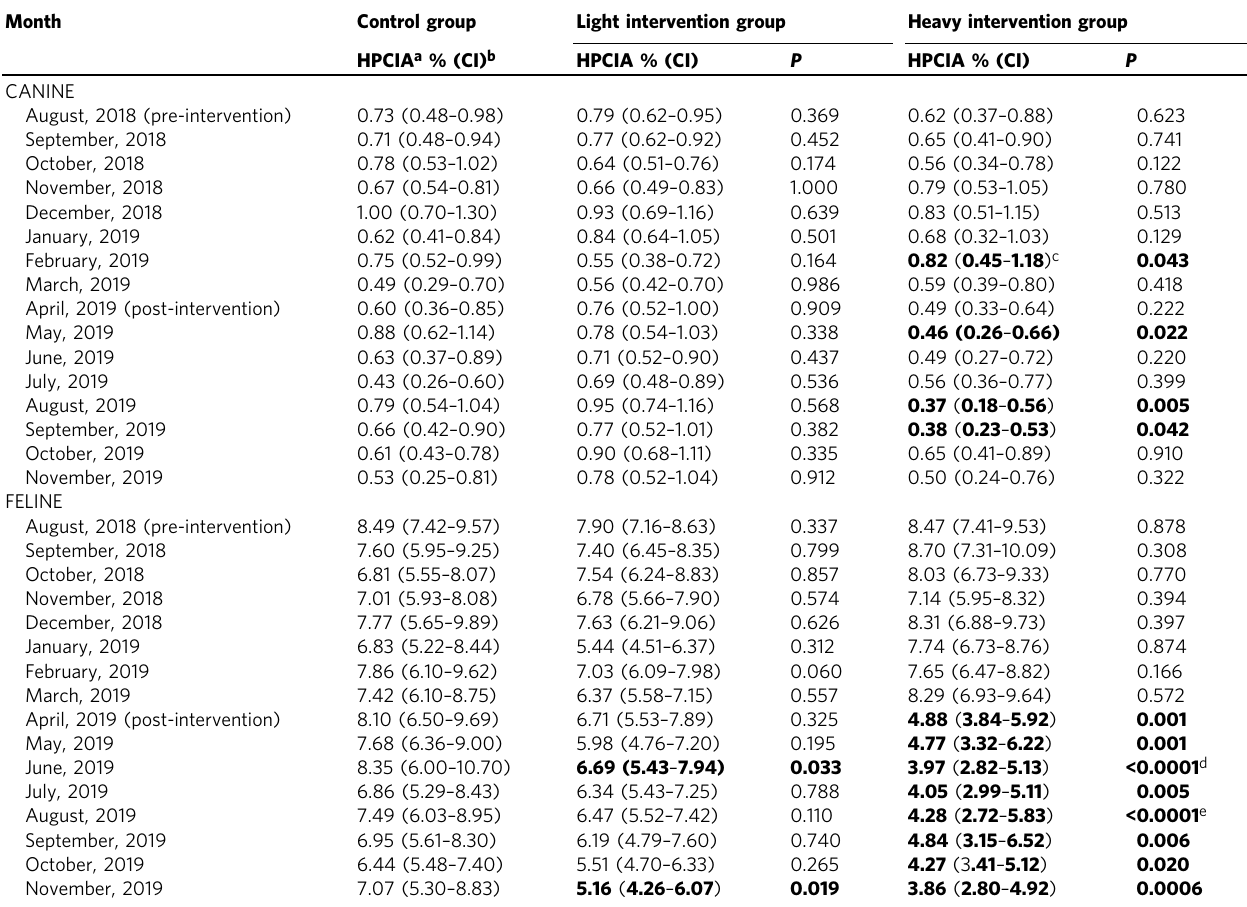
Table 4 Canine and feline HPCIA prescription as a percentage of total consultations, summarised by month between August 2018 and November